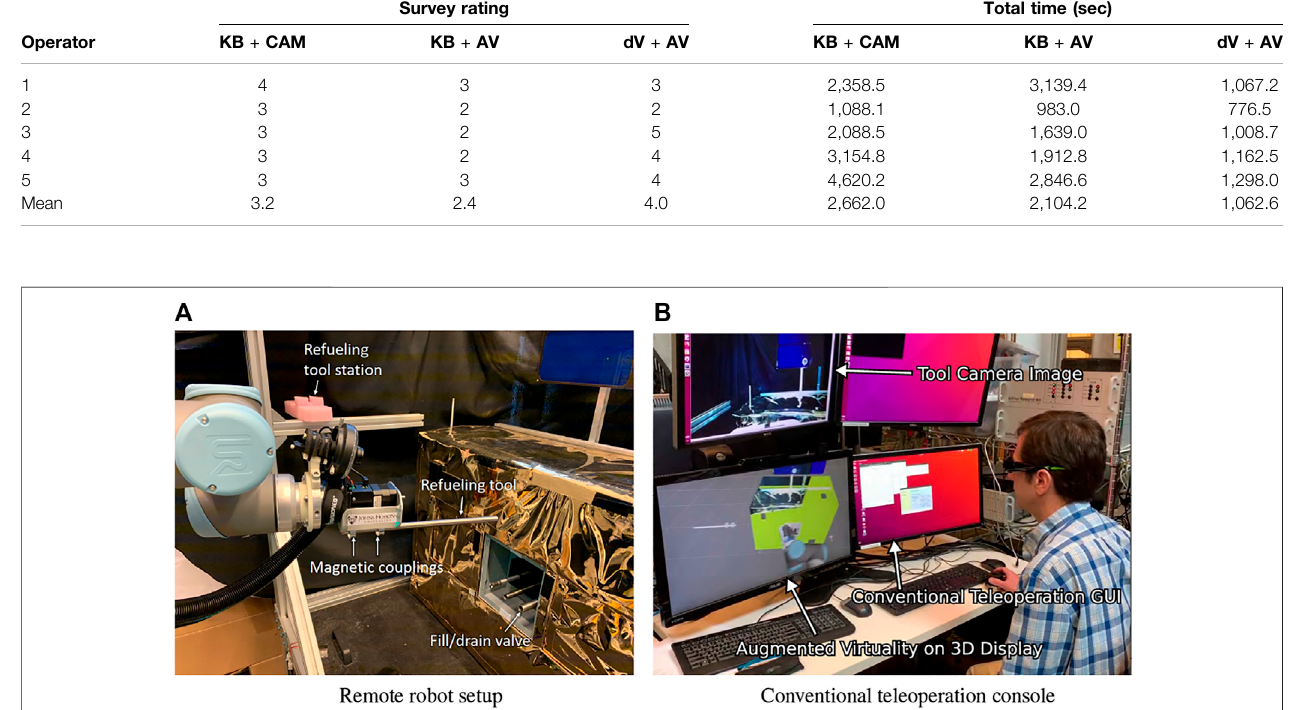
TABLE 2 | MLI hat cutting experiment: Post-experiment survey results (1 (cid:1) very easy, 5 (cid:1) very hard) and total times (seconds) required by each robot operator for each interface. Survey rating